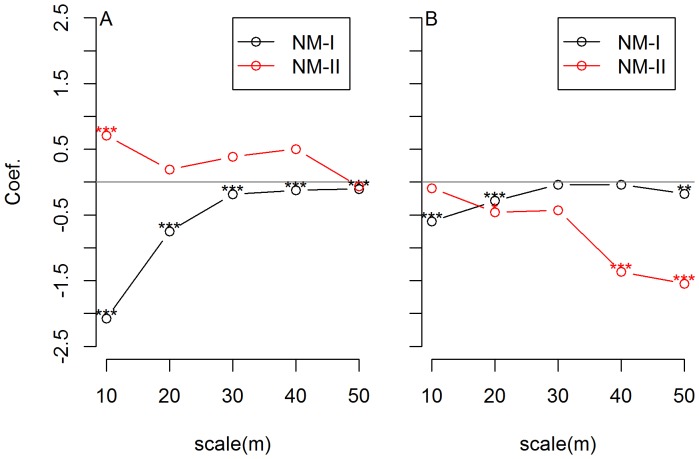
The relationship between phylogenetic similarity and phylogenetic turnover along five spatial scales for BCI and DHS.The relationship between phylogenetic similarity and phylogenetic turnover based on spatial simultaneous autoregressive error model across scales for the BCI (A) and DHS (B) plots. Y-axis is regression coefficient of ses.RaoD against NRI. The independent variable is phylogenetic diversity index NRI and the dependent variable is phylogenetic turnover ses.RaoD, which is the standardized effect size of RaoD of a null model. Null Model-I (NM-I) shuffles species names across all species in each plot, while Null Model-II (NM-II) randomizes the location of mortality according to species- and size-specific survival probability and the location of recruitment according to species-specific dispersal ability. The black line was from NM-I, and the red line from NM-II. ‘**’ indicates p value<0.001 and >0.0001. ‘***’ indicates p value<0.0001.